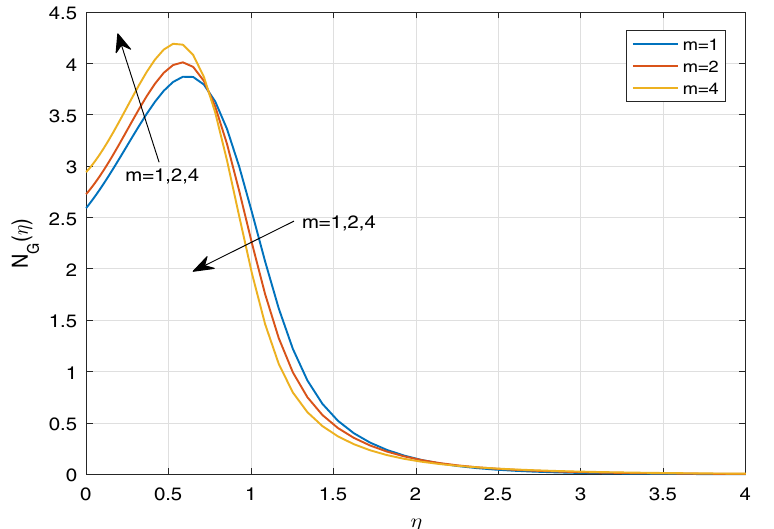
Figure 17. Sketch of N G against m .